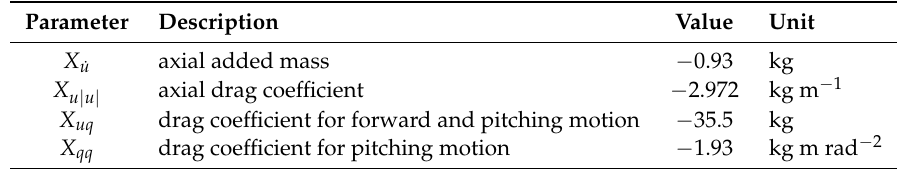
Table A4. Parameters of the surge equation of motion taken from [24].